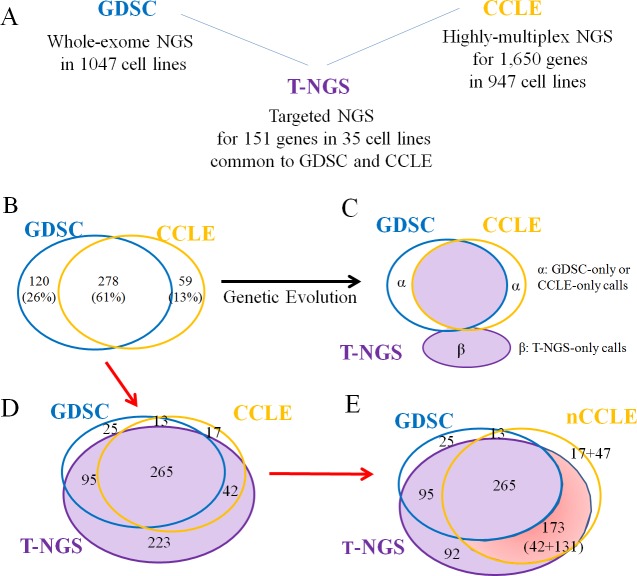
FN errors and inconsistent mutation calls between GDSC and CCLE.A. Comparison of results from GDSC, CCLE, and T-NGS. B. Inconsistent mutation calls between GDSC and CCLE for 151 genes in 35 cells. C. Expected mutational profiles from 3 independent laboratories, if genetic evolution is the major reason for the inconsistent mutation calls. If genetic evolution were the major factor for the difference between GDSC and CCLE, T-NGS would not contain calls specific to GDSC or CCLE (areas marked as α), but rather, additional calls specific to T-NGS (β). D. Inconsistent mutation calls among T-NGS, GDSC and CCLE. The number of calls found only in GDSC (25) or CCLE (17) was only about 10% of the T-NGS-only calls (223). In addition, 62% (111/179) of the inconsistent calls between GDSC and CCLE were found in our T-NGS. E. Consistency of T-NGS with later version of CCLE. In the later version of the CCLE database, 59% (131/223) of the T-NGS-only mutation calls in C were updated as newly identified mutations.